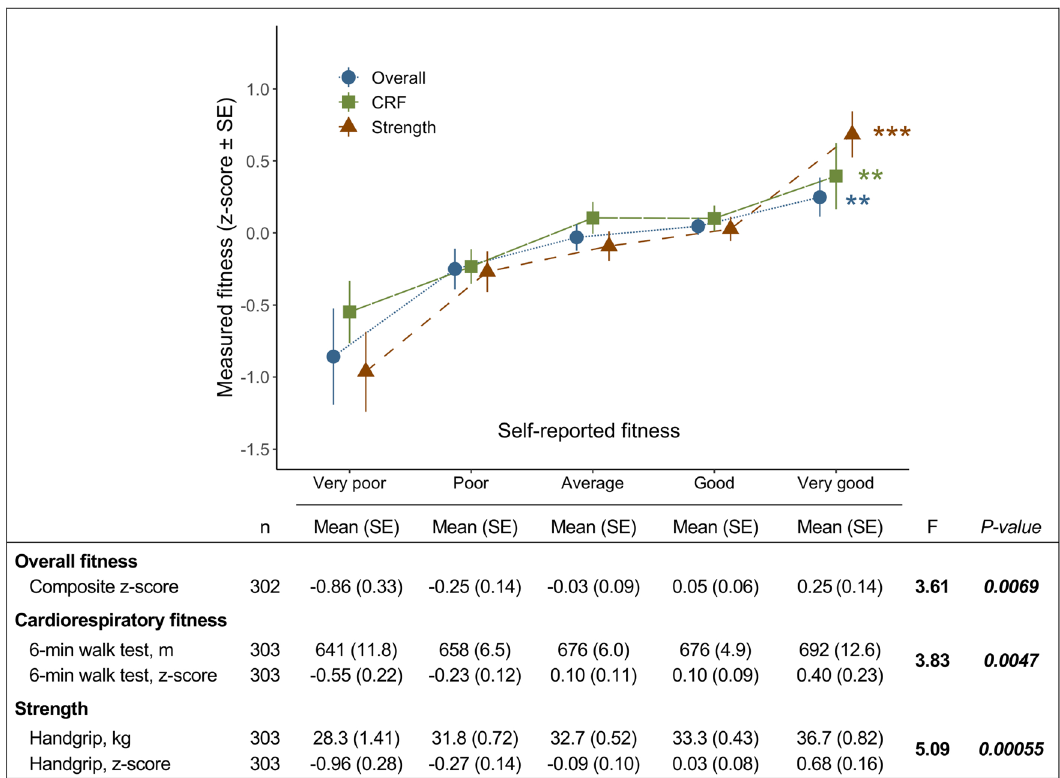
Figure 2. Comparison between self-reported (International FItness Scale, IFIS) and measured fitness in early pregnancy. The plot shows group means with standard error (SE) for each level of self-reported fitness and the corresponding fitness test. Values shown are actual fitness test results as well as standardized z-scores for easier comparison. Self-reported overall fitness is compared with a composite score computed as the average of the z-scores from the two different fitness tests, i.e., handgrip and 6-min walk test. CRF cardiorespiratory fitness: self-reported CRF compared with 6-min walk test. Self-reported muscular strength is compared with handgrip strength test. F-statistics and p-value from one-way analysis of variance (ANOVA). Significance level from the overall ANOVA test for each fitness type is indicated with symbols: ‘***’ p < 0.001, ‘**’ p < 0.01, ‘*’ p <